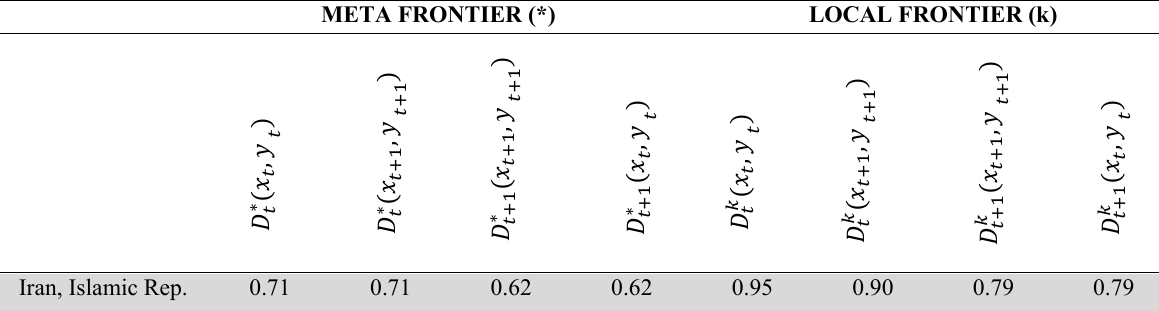
Values of distance functions with Meta Frontier locally for Iran META FRONTIER (*) LOCAL FRONTIER